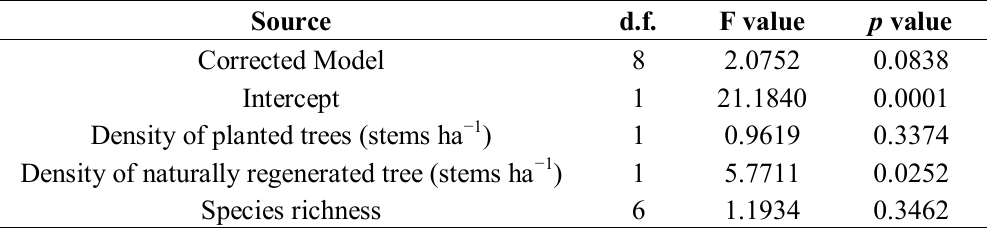
Table 3. The influence of species richness on stand basal area using tree density as